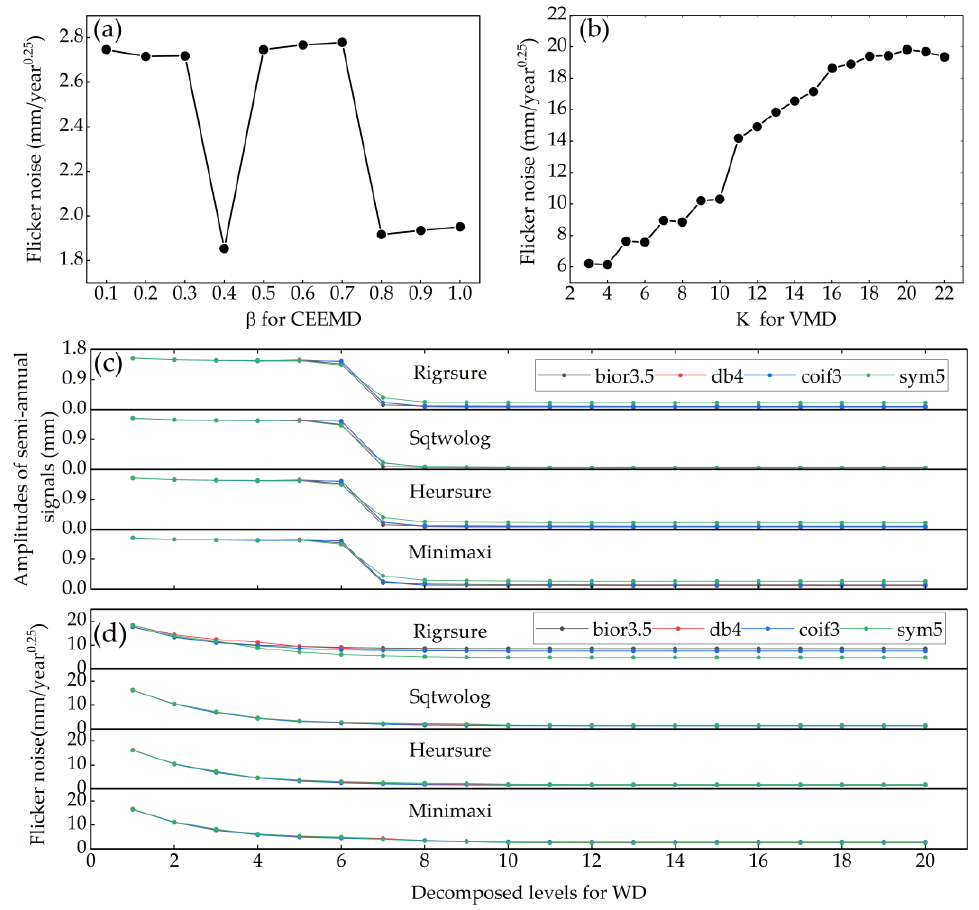
Figure 1. The variation of flicker noise with different options for CEEMD ( a ), VMD ( b ) and WD ( c , d